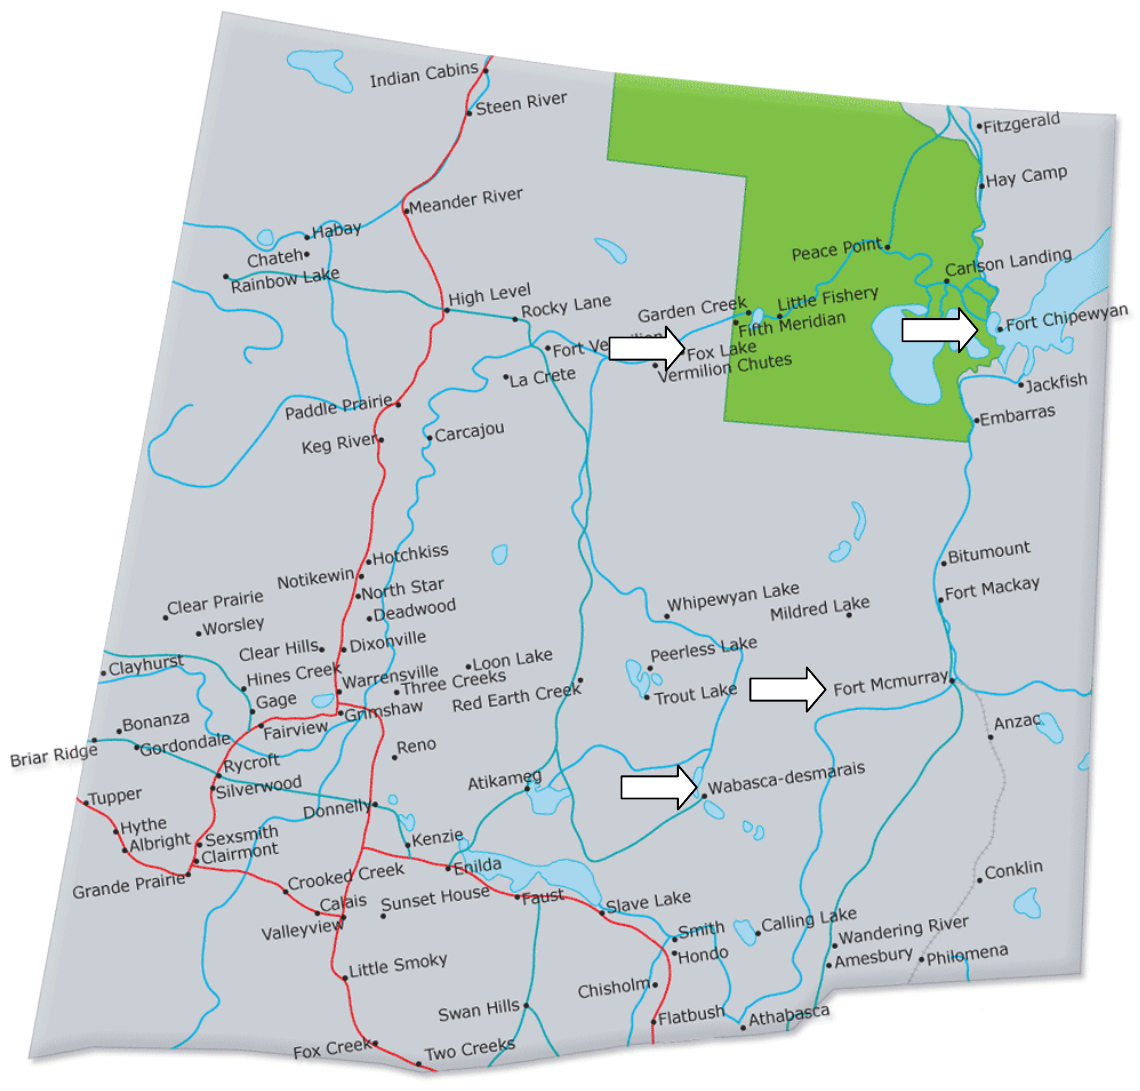
Figure 2 : Location of study communities, Alberta,